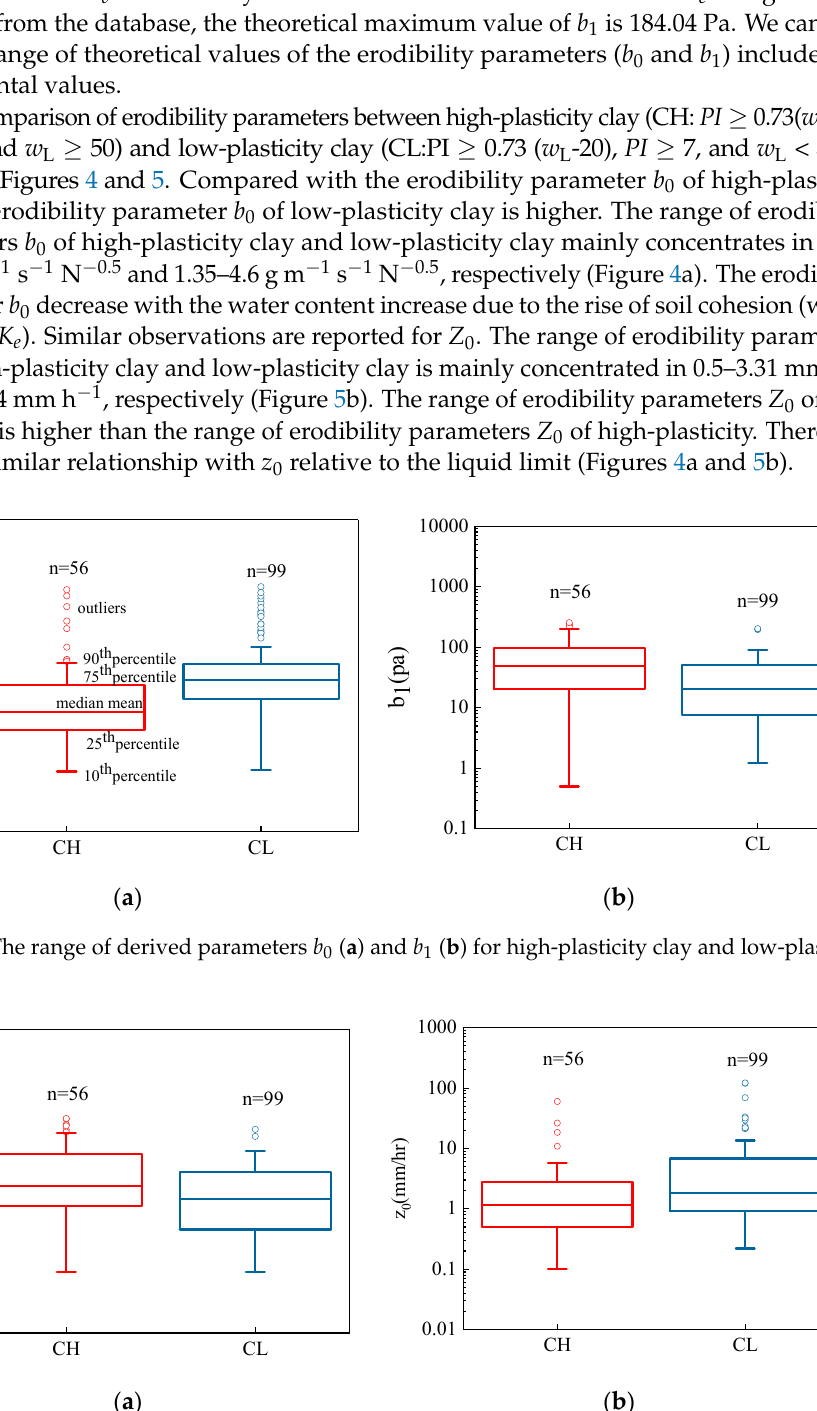
Figure 5. The range of derived parameters τ c ( a ) and Z 0 ( b ) for high-plasticity clay and low-plasticity clay.